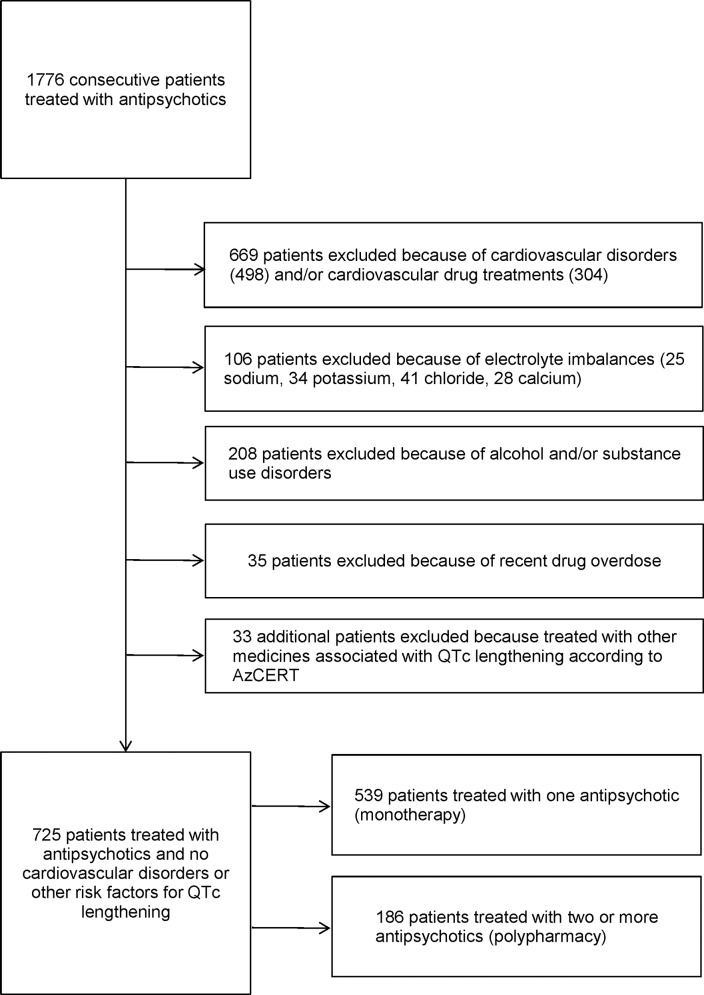
Flow chart of inclusion and exclusion criteria of cohort of patients treated with antipsychotic drugs.